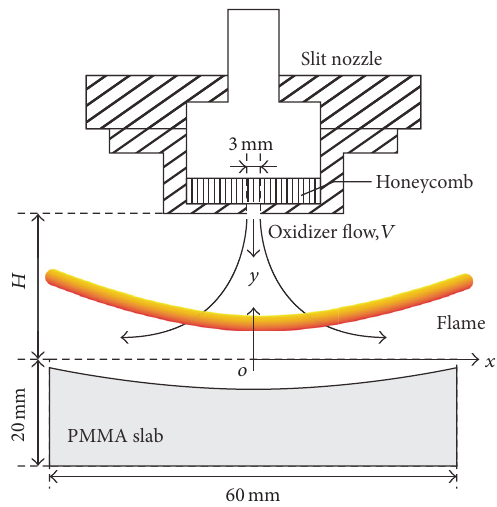
Figure 1: Schematic image of experimental